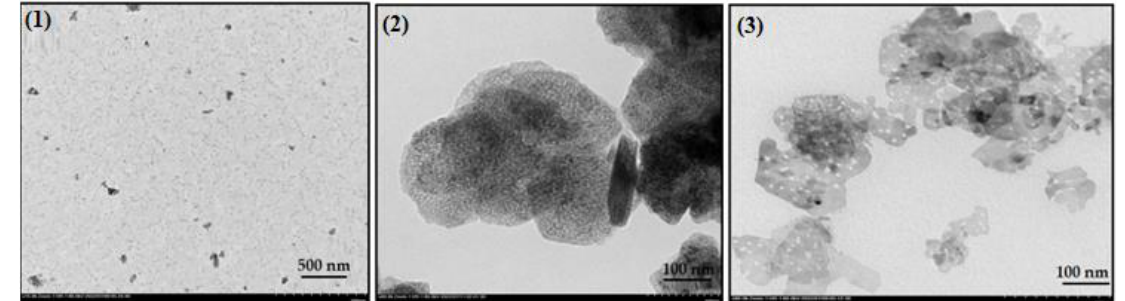
Figure 4. TEM image of catalyst - 1 ( 1 ), catalyst - 2 ( 2 ), and catalyst - 3 ( 3